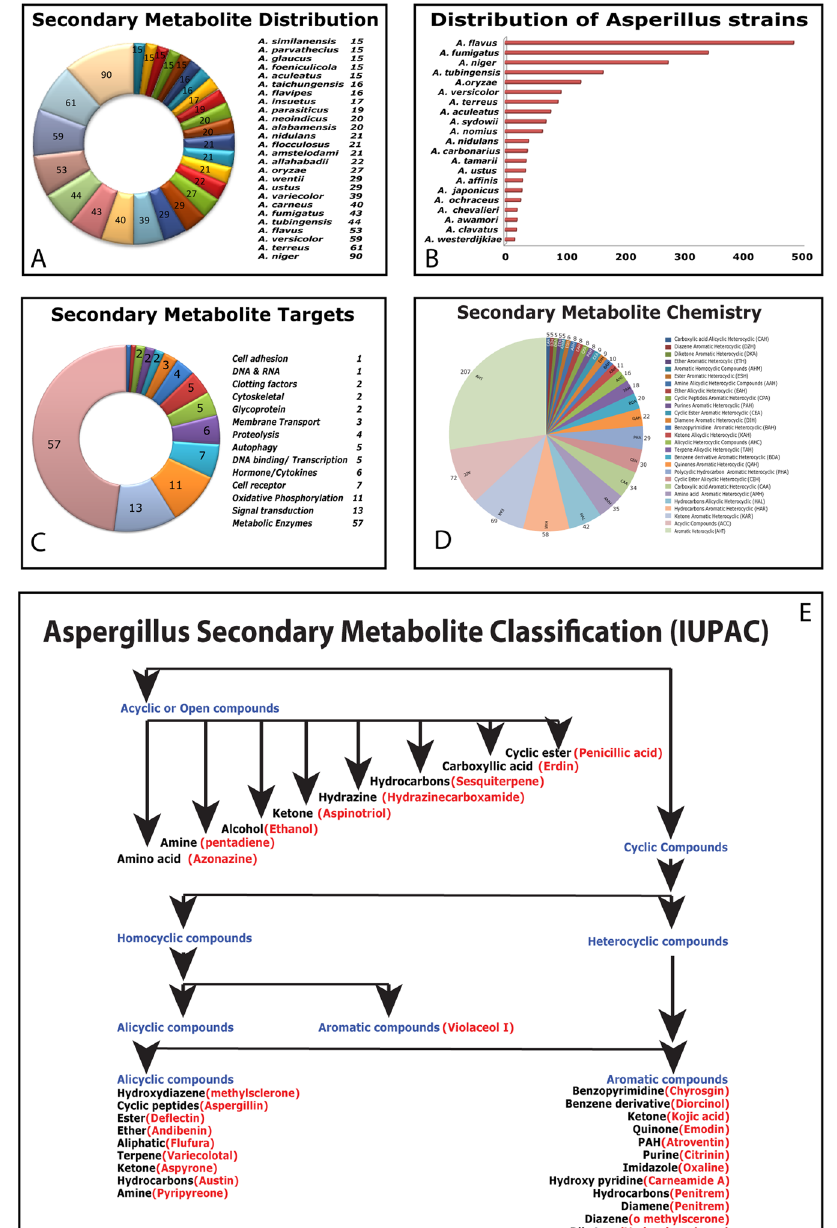
Figure 2. Analysis of the data collected for assimilation in to A2MDB: ( A ) pie chart representing the number of metabolites identified from major Aspergillus species, ( B ) bar graph shows the clinical distribution of biologically, medically and important strains of major Aspergillus species, ( C ) gene ontology based classification of cellular targets based on molecular function, ( D ) Distribution of secondary metabolites based on their chemical property, ( E ) IUPAC based classification of secondary metabolites in to various chemical compounds shown with examples under each